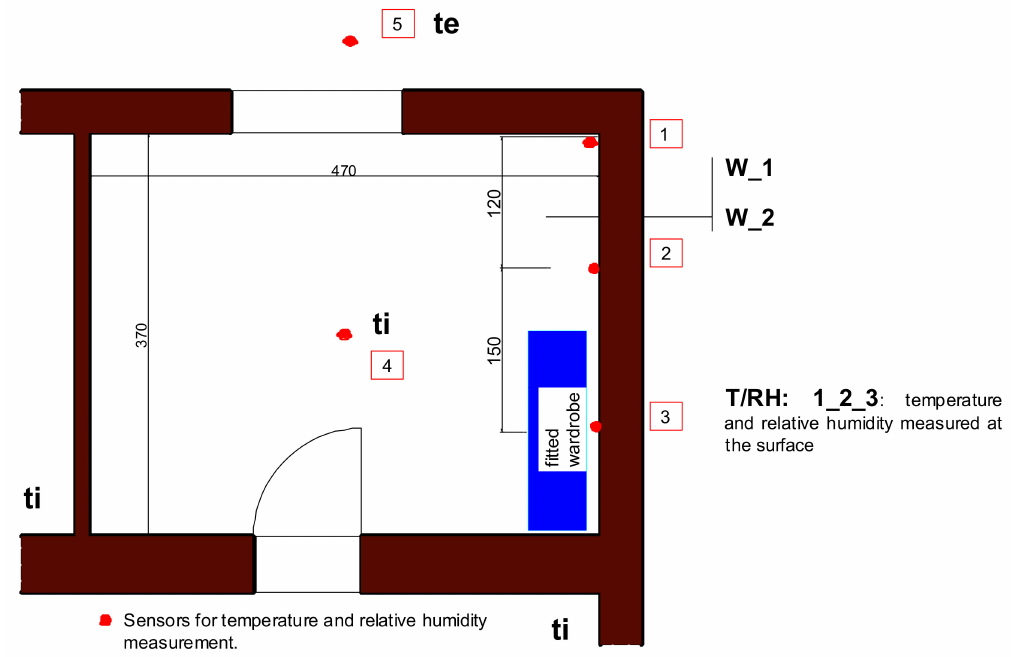
Figure 5. Diagram of an exemplary room with the layout of sensors.